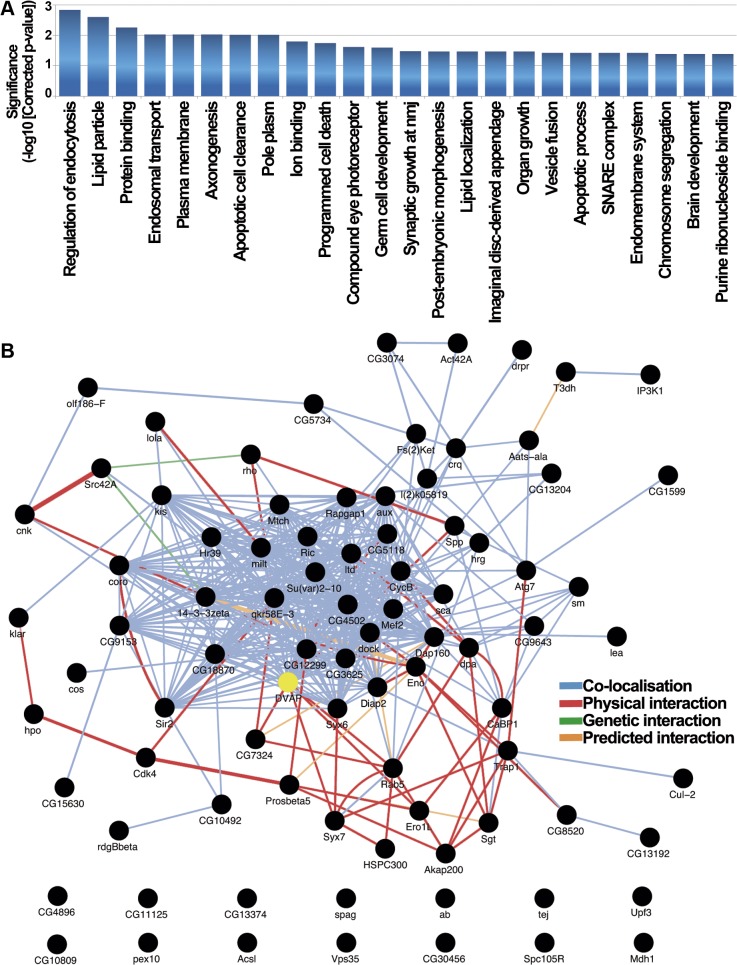
Functional role and interactome analysis of genetic modifiers in Drosophila.(A) Drosophila functional categories overrepresented in the genetic modifiers list. Enrichment significance is expressed as the-log10 transformed Benjamini-Yekutieli corrected p-value resulting from hypergeometric tests of GO-term enrichment. In this process we de-correlate the modifier gene list annotated GO-tree to remove GO-term conditional dependence using the weighted elimination method [43] so that we can perform multiple testing correction. (B) Drosophila interaction network for DVAP-P58S screen hits identifies connections between most of them. 72 of the 85 genes that modify the DVAP-P58S phenotypes are annotated as black circles while network edges are colored accordingly to the type of interaction. 13 of the 85 genes are excluded from the interactome that includes also DVAP (yellow).